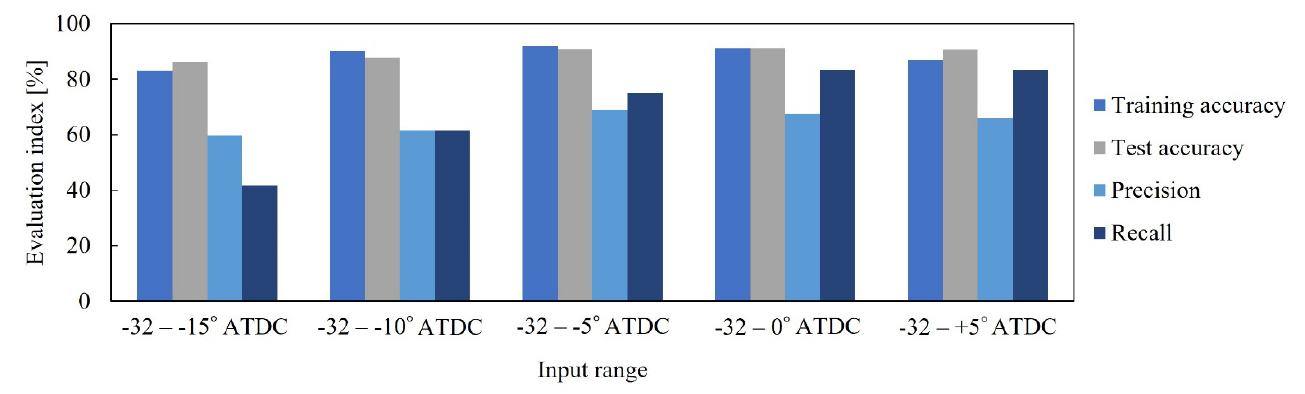
Figure 8. Effects of changing the end CA on prediction.